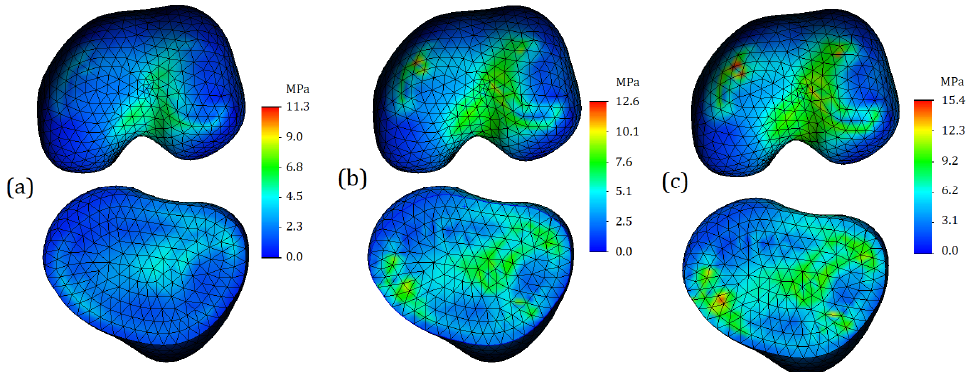
Figure 8. Von Mises stress plots on contact surfaces of the bones in case of walking: ( a ) With mild cartilage sti ff ness; ( b ) With moderate cartilage sti ff ness; ( c ) With severe cartilage sti ff ness.